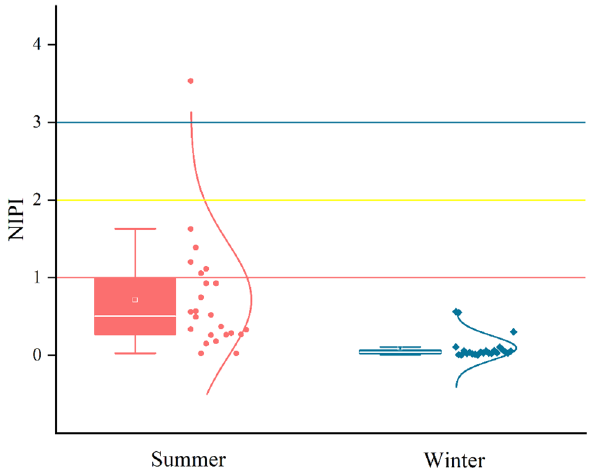
Figure 6. NIPI value of PAHs in park